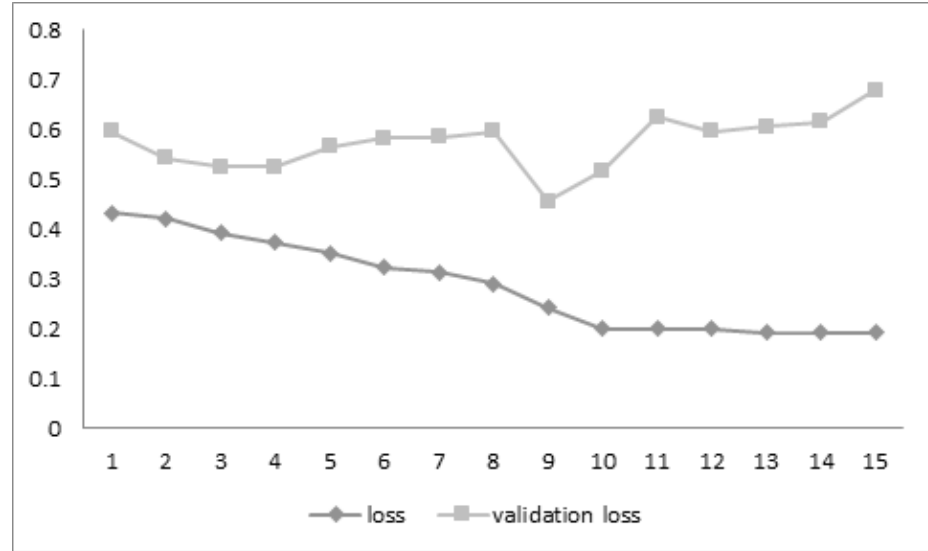
Figure 2. Graph comparisons for the loss vs. validation loss